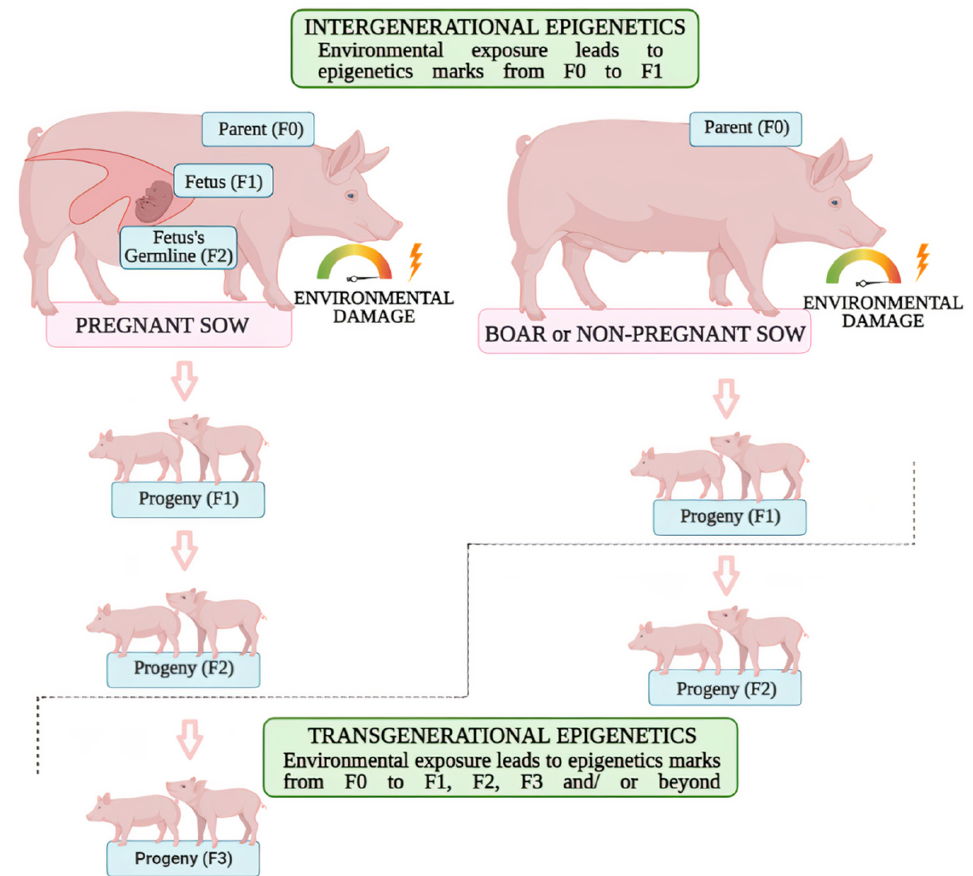
Figure 1. Intergenerational and transgenerational epigenetic inheritance in porcine models. When a swine (F0) is exposed to an environmental insult, somatic and germ cells will potentially affect their epigenome. In addition, if it is a pregnant sow, the fetus (F1) and its germ cells—which will give rise to a next generation—will be directly affected (F2). So, if these epigenetic marks contained in the fetus’s germ cells remains for subsequent generations (F3 and beyond), there will be a transgenerational epigenetic event.